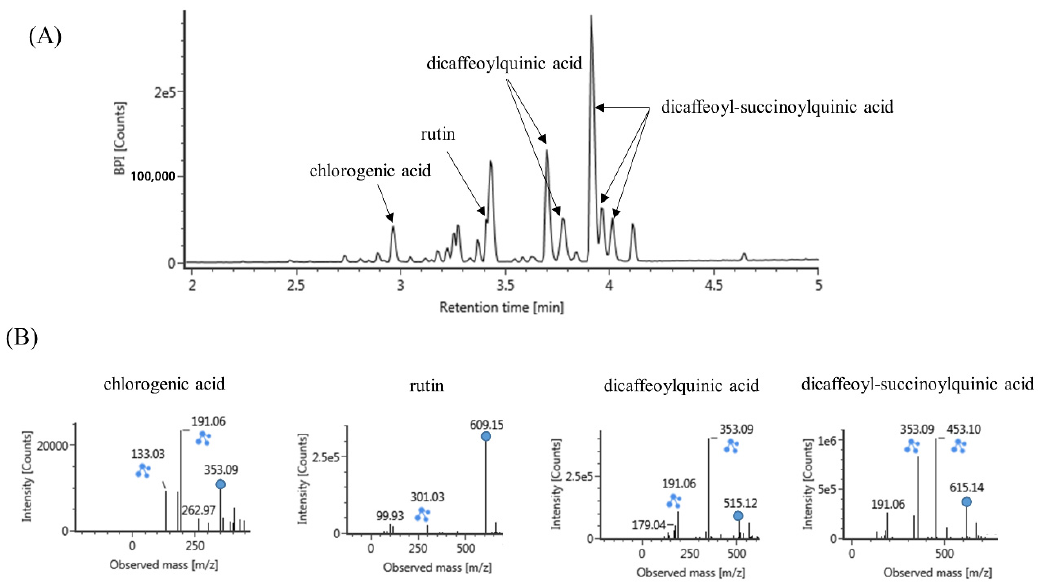
Figure 4. ( A ) Representative chromatogram of Chrysanthemum coronarium L. extract ( B ) and spectra of major compounds. The extract was analyzed using UPLC-Q-TOF MS and its major compounds were tentatively identified using the online databases connected to the UNIFI software (Waters).